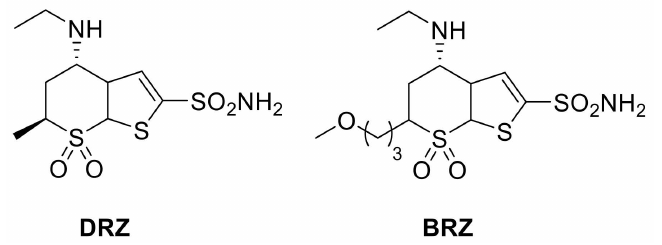
Figure 2. Structures of clinically approved dorzolamide ( DRZ ) and brinzolamide ( BRZ